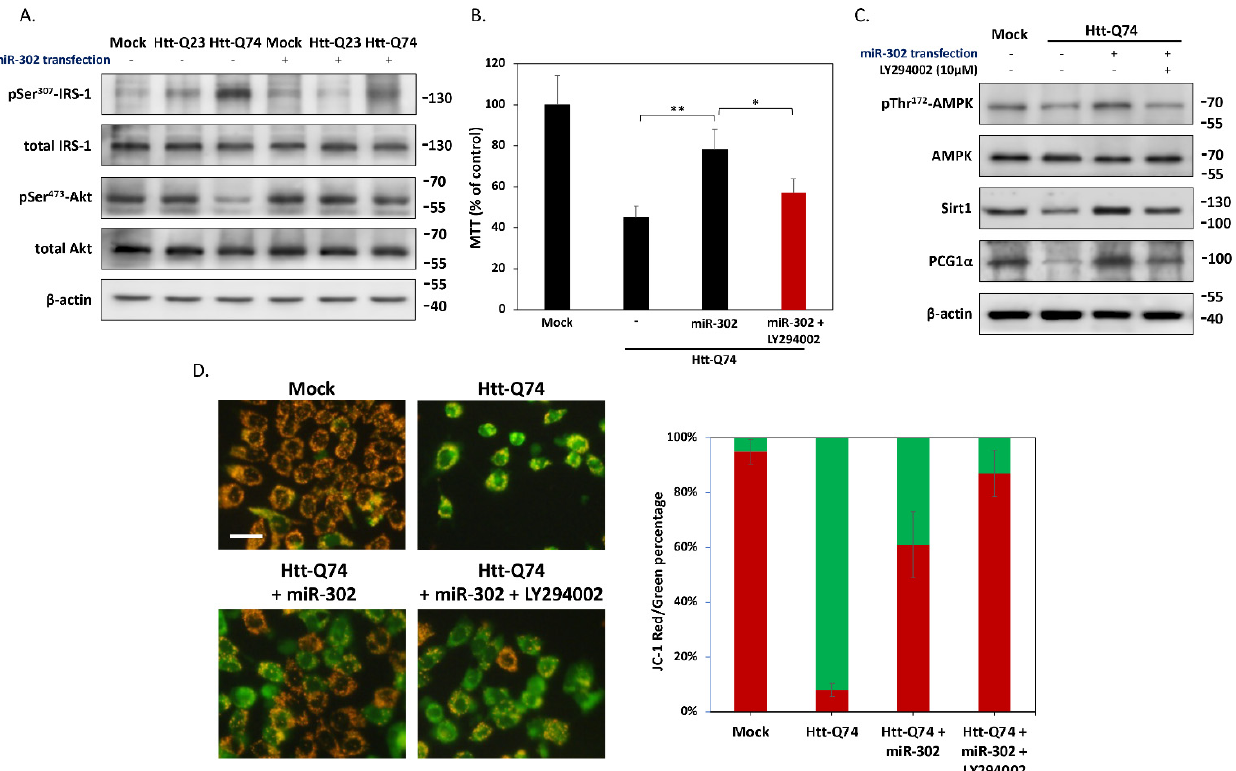
Figure 4. miR-302 upregulates Sirt1/AMPK-PGC1 α pathway and preserves mitochondrial function. ( A ) The protein levels of IRS-1 and downstream molecules Akt by using western blotting. ( B ) MTT assays show the LY294002 co-treatment inhibits the protective effect of miR-302 in mHtt-Q74-overexpressing cells. ( C ) Western blots show that miR-302 upregulates Sirt1, AMPK and PGC1 α , three proteins positively associated with mitochondrial biogenesis and mitophagy. On the contrary, co-treatment with 20 µ M LY294002 markedly blocks the effects caused by miR-302, suggesting the protection by miR-302 is dependent on insulin signaling. ( D ) Representative images of mitochondrial membrane potential are demonstrated by JC-1 staining, and cells observed with green and red fluorescence are also quantified in percentages. The increase of JC-red shows that miR-302 can protect against mHtt-induced mitochondrial dysfunction (JC-green). However, LY294002 prevents the effects of miR-302, suggesting that insulin signaling is essential for the protection of miR-302. All values are presented as mean ± SEM. Significant difference was determined by using the multiple comparisons of Dunnett’s posthoc test for * p < 0.05 and ** p < 0.01. Scale bar represents 10 μ m.